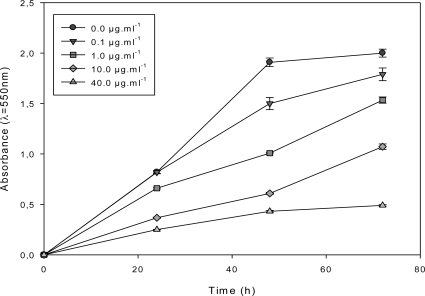
Growth kinetics of MCF-7 continuously treated with the DT DCM sub-fraction F1.4.